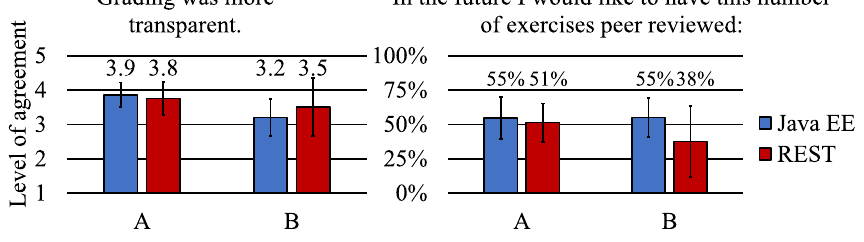
Fig. 4. Transparency of grading and number of peer review exercises